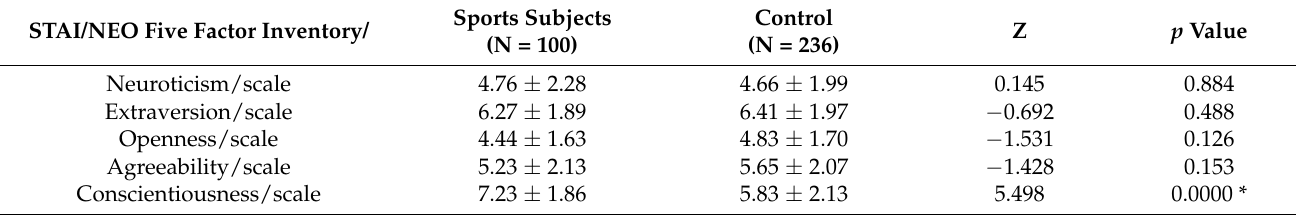
Table 2. NEO Five-Factor Inventory results (sten scale) and between healthy control and sports subjects. STAI/NEO Five Factor